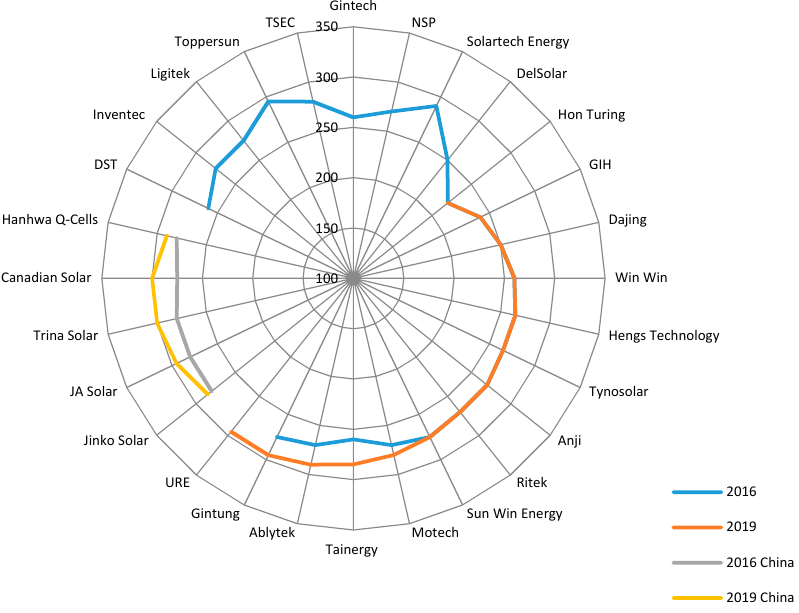
Figure 14. c-Si poly module power (Wp) of Taiwanese manufacturers within the